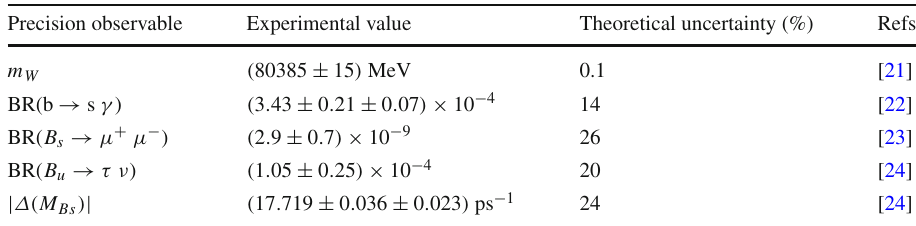
used to constrain the parameter space. Note that a newer and slightly more precise measurement BR( B s → μ